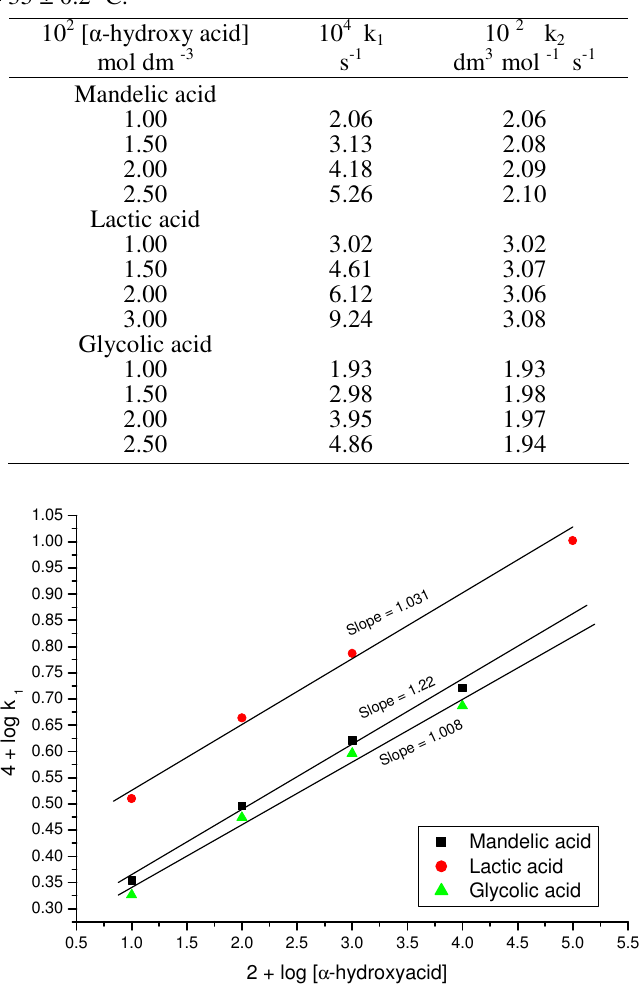
SO ] = 1.00 mol dm -3 , [CTAB]= 2.00 x 10 -3 mol dm -3 2 4